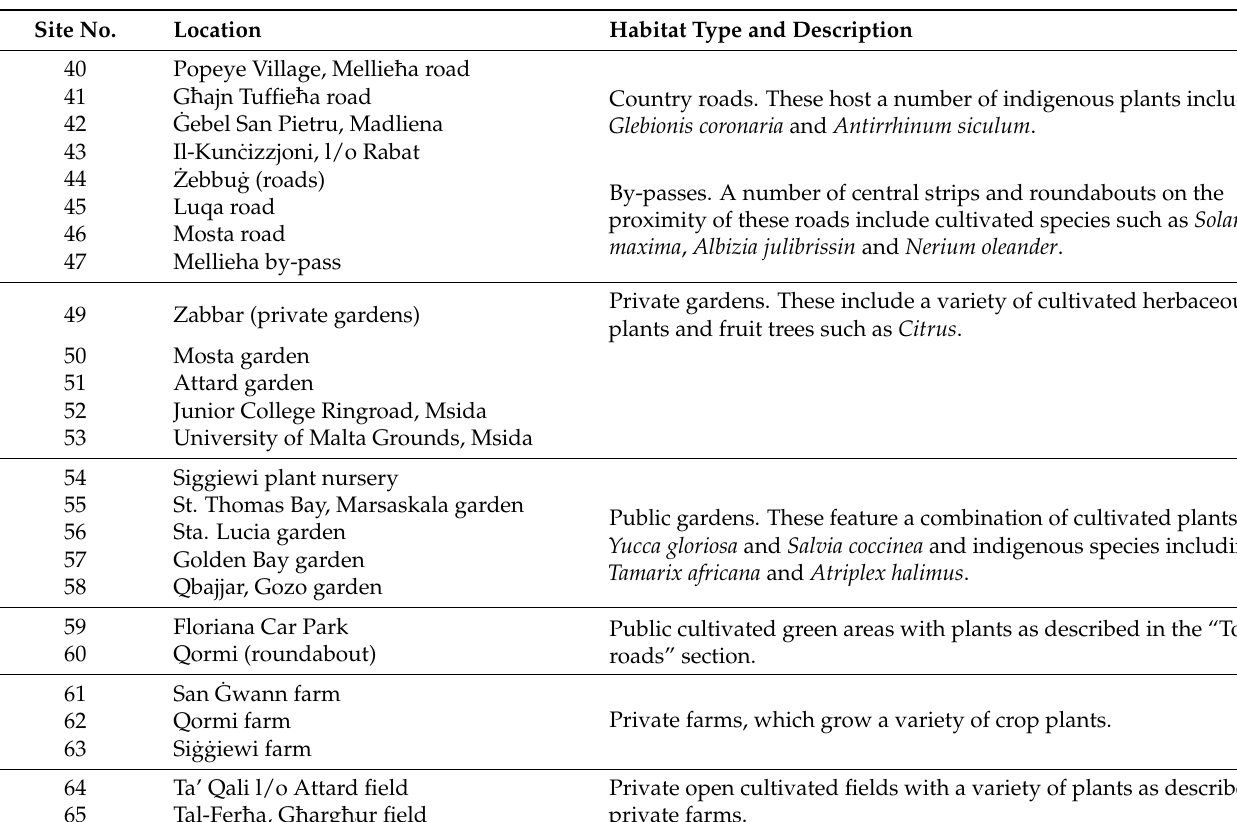
Figure 1. Map of the Maltese Islands (Gozo and Malta) showing the locations where data were collected between 2015–2022 (with names, habitat description and predominant vegetation of locations indicated in Table 1). Table 1. Locations where data were collected for this study: habitat type and brief description. Site No.